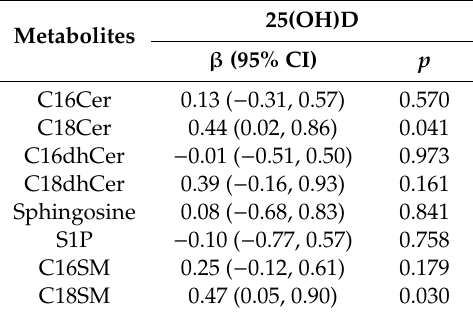
Figure 1. Effects of vitamin D 3 supplementation on serum ceramide levels and sphingomyelin levels. The upper left is C16Cer, upper right is C18Cer, lower left is C16SM, and lower right is C18SM. Y-axis is the change in standardized levels of ceramide or sphingomyelin. Red lines indicate 25 percentile, mean and 75 percentile of standardized levels of ceramide or sphingomyelin in each group. Abbreviations: C16Cer, N -palmitoyl-sphingosine (d18:1 / 16:0); C18Cer, N -stearoyl-sphingosine (d18:1 / 18:0); C16SM, palmitoyl sphingomyelin (d18:1 / 16:0); C18SM, stearoyl sphingomyelin (d18:1 / 18:0). Table 3. Adjusted associations between the changes in sphingolipids and the changes in 25(OH)D concentrations